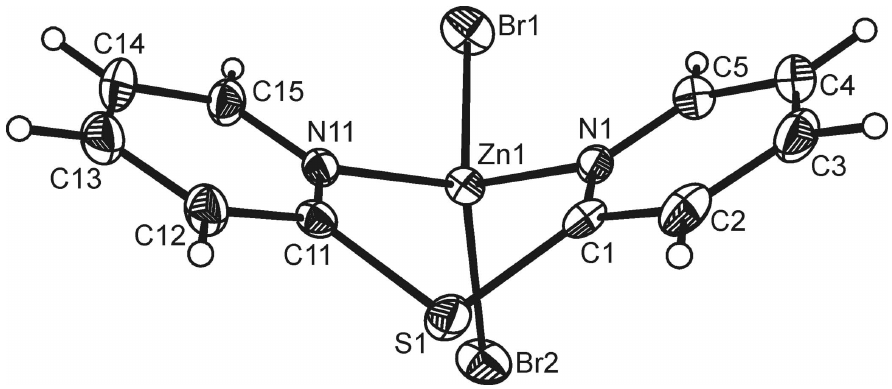
Figure 1 Crystal structure of compound I showing the labelling scheme, and displacement ellipsoids drawn at the 50% probability